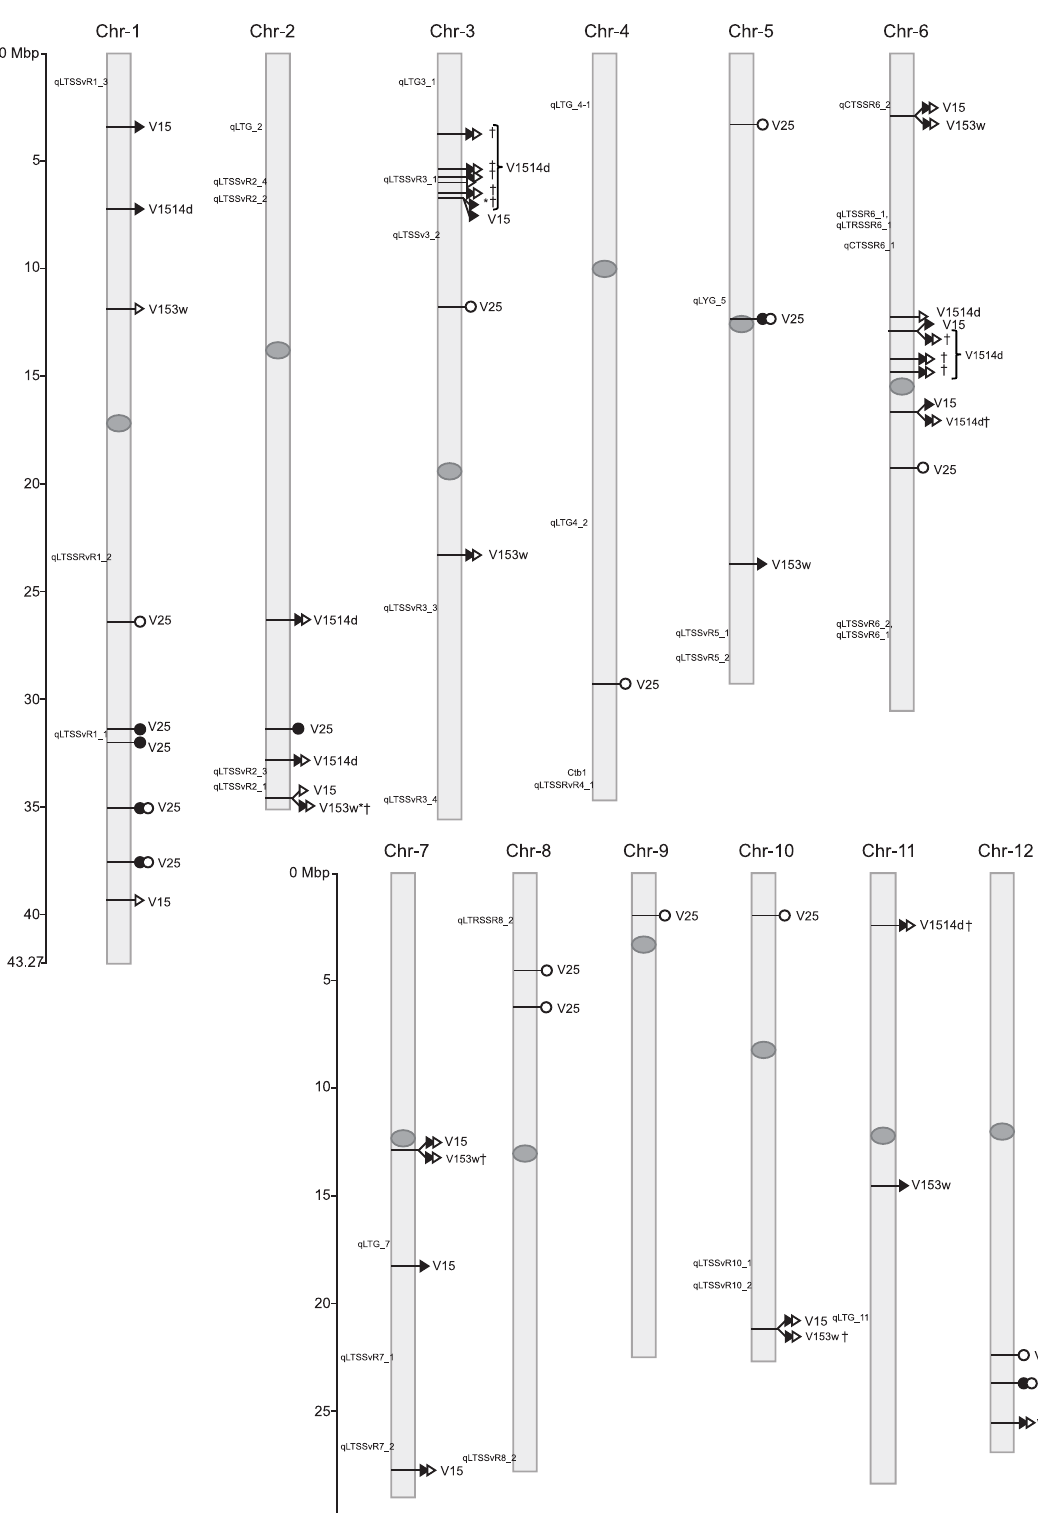
Fig 4. Chromosome position of the SNP markersassociated with coleoptile growth rate of rice seeds germinated at 25˚C (V25; ellipses) and to traits describing growth rate when seeds were germinated at 15˚C (V15, V1514dand V153w; triangles). Associationanalyseswere performed with the completeset of 200 rice varieties (white symbols) and with the 180 japonicacultivars (black symbols). †, markers with p -value < q -value, when q -value= 0.1 i /1672; * , markers with p - values < 0.00005. In italics, previouslydescribedQTLs [27]. https://doi.org/10.1371/journal.pone.0183416.g004 PLOS ONE | https://doi.org/10.1371/journal.pone.0183416 August 17,